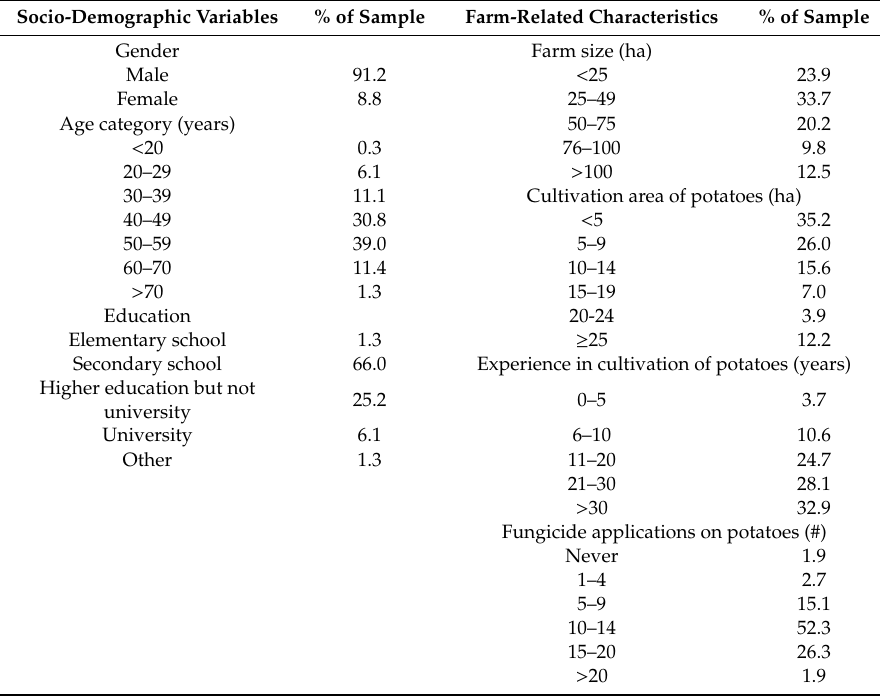
Table 2. Socio-demographic and farm-related characteristics ( n =